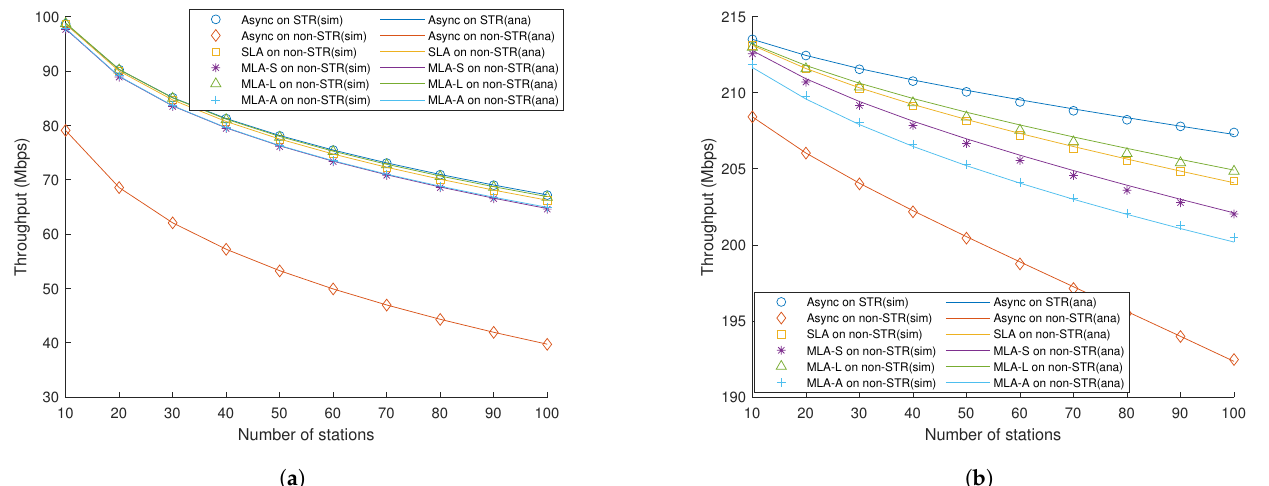
Figure 10. Sum of saturated throughput for all links, ( a ) when RTS/CTS exchange is off, and ( b ) when RTS/CTS exchange is